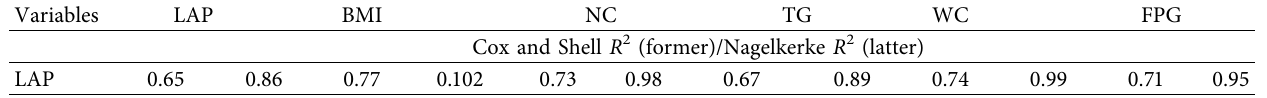
Table 8: The incremental diagnostic performance of LAP for predicting hypertension.